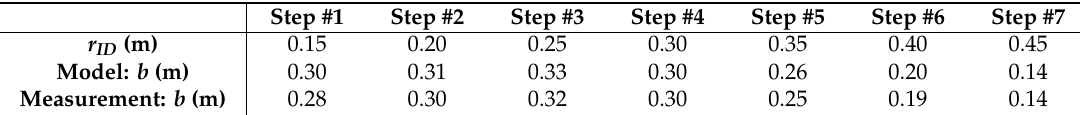
Table 8. Comparison of measurement and calculation results for IZ boundaries.